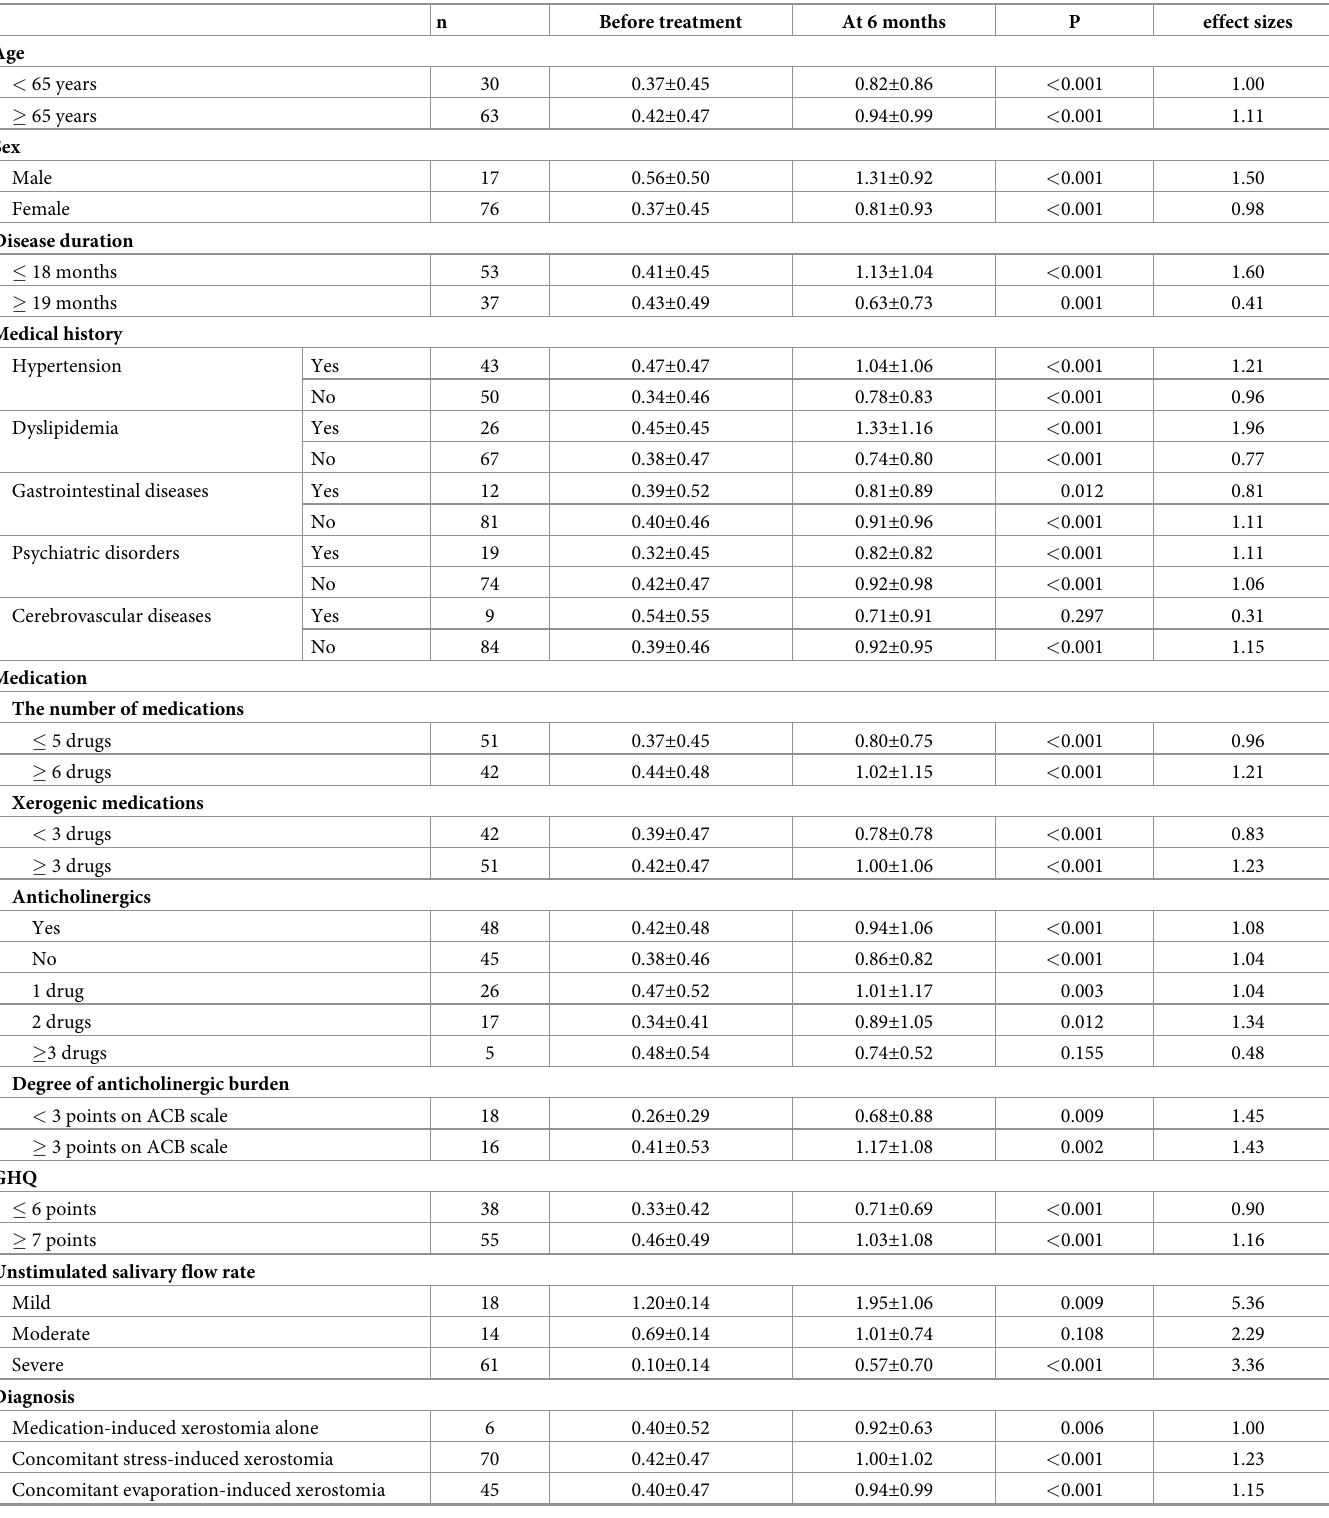
Table 3. Salivary flow